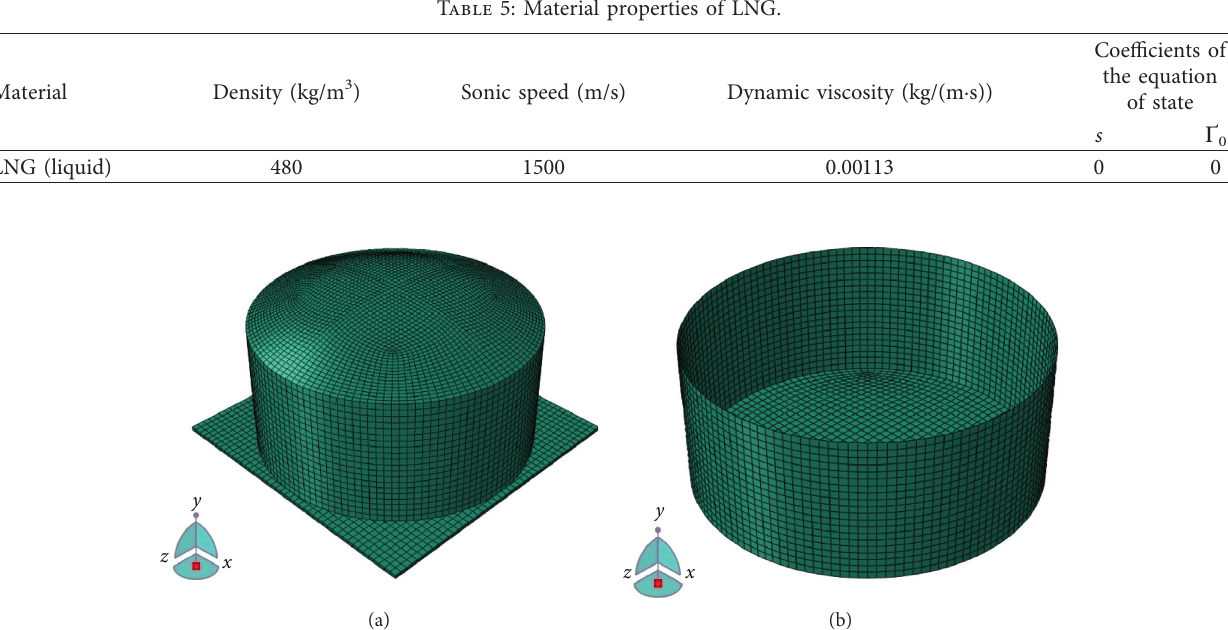
Figure 7: FEM of the LNG storage tank. (a) The outer tank. (b) The inner